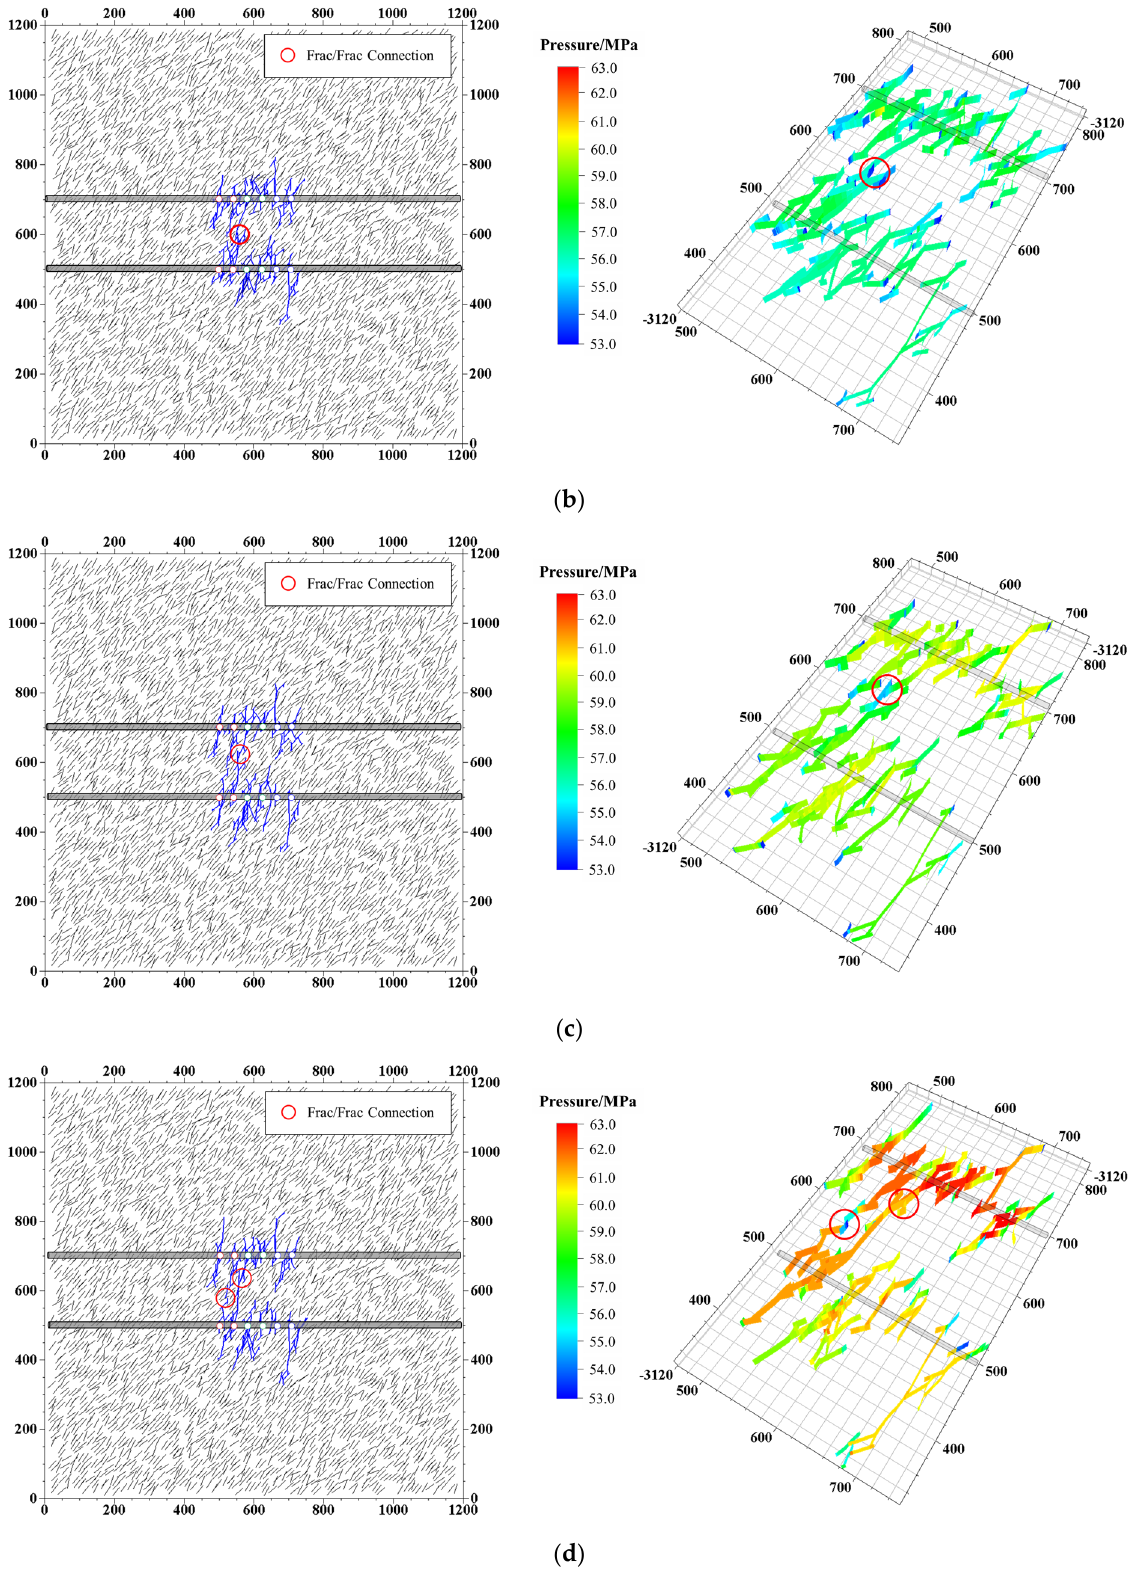
Figure 14. HF geometries for different horizontal stress anisotropies: ( a ) ∆ σ h = 0 MPa; ( b ) ∆ σ h = 5 MPa; ( c ) ∆ σ h = 10 MPa; ( d ) ∆ σ h = 15 MPa.